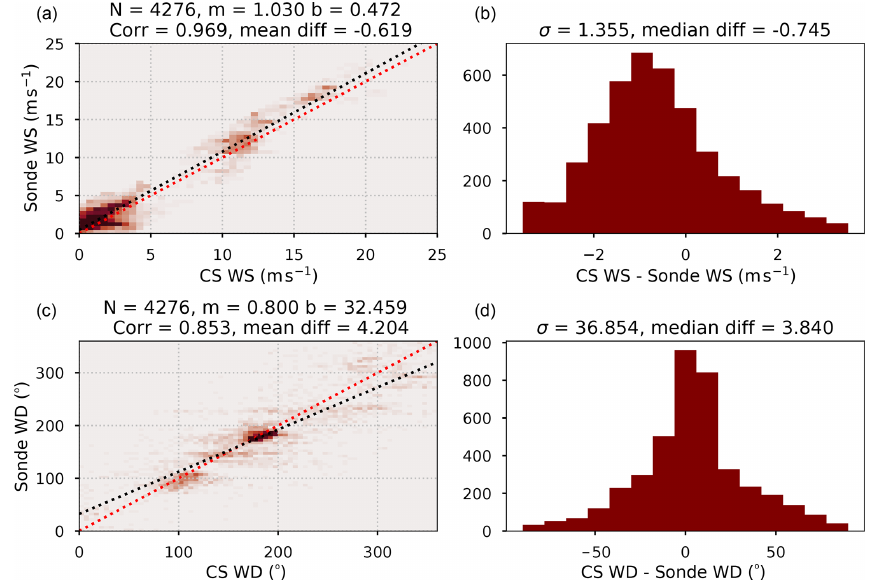
Figure 7. Similar to Fig. 4 but comparing kinematic measurements from the radiosondes and the CopterSonde.